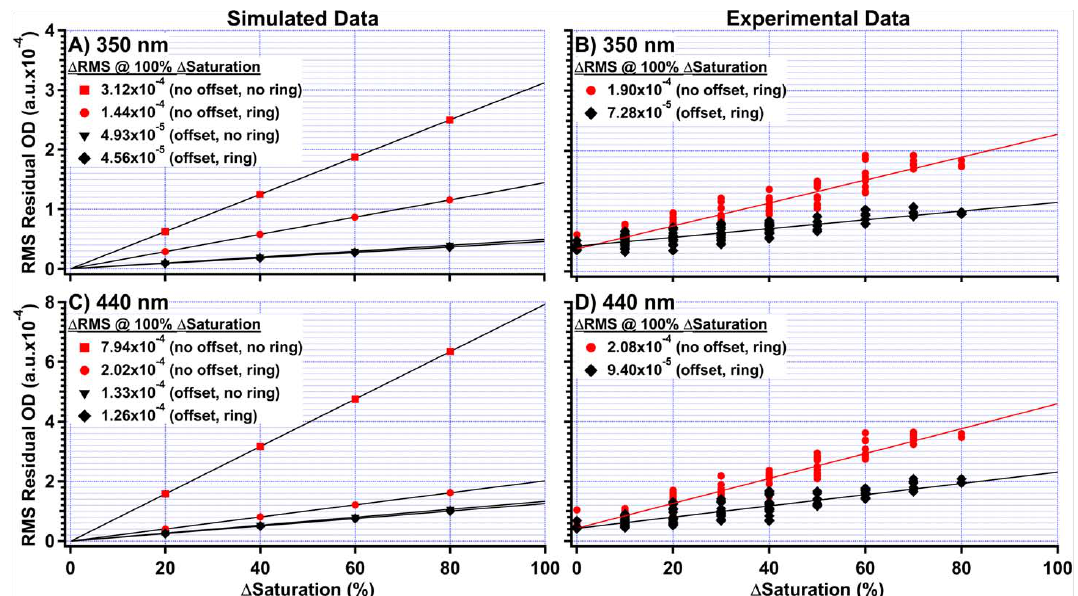
Fig. 4. Correlation of simulated ( A and C ) and experimental ( B and D ) data testing the non-linearity of our CCD detector at two different wavelengths: 350nm ( A and B ) and 440nm ( C and D ). Coefficients for linear regressions fit to the data were extrapolated to determine the RMS value corresponding to 100% of the dynamic range of the detector, and these values are listed for the different fit scenarios in each of the